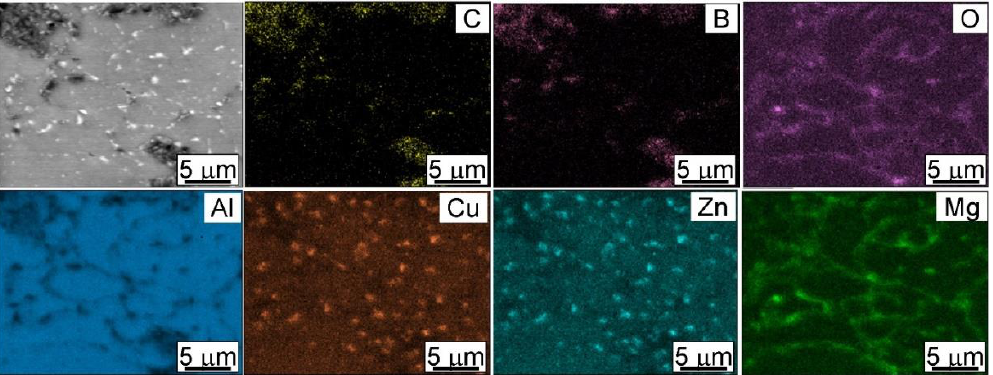
Figure 5. SEM and corresponding EDS mapping micrographs of AA7075-3wt%B 4 C spark plasma sintered at 10 min.